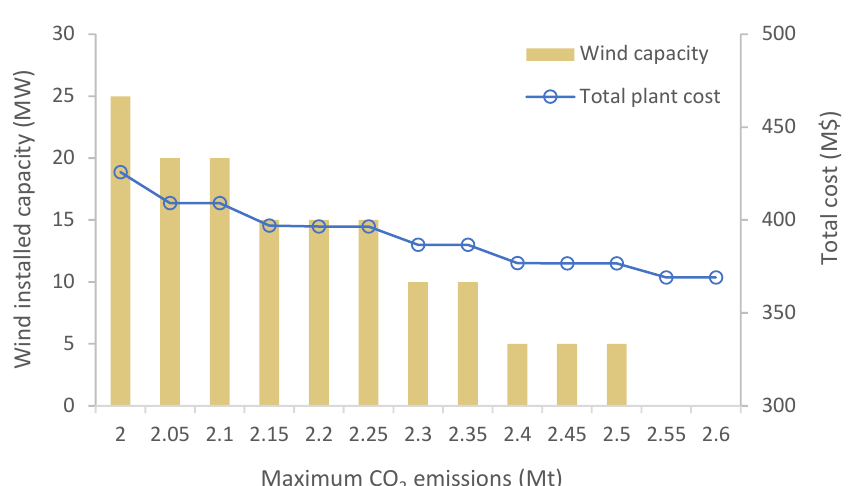
Figure 9. Characteristics of the designs identified through the selection process at the different maximum levels of CO 2 emissions. The bars represent the optimal wind capacity to be installed. The empty dots represent the total plant cost.